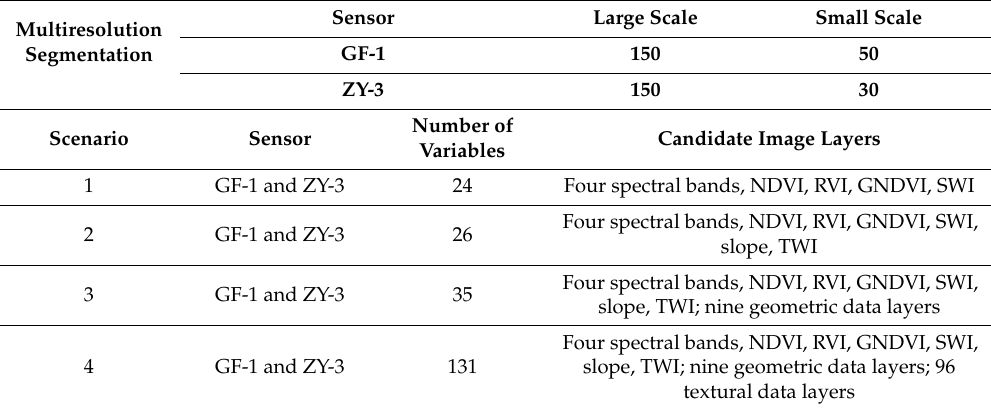
Table 5. Segmentation scales and input layers for each